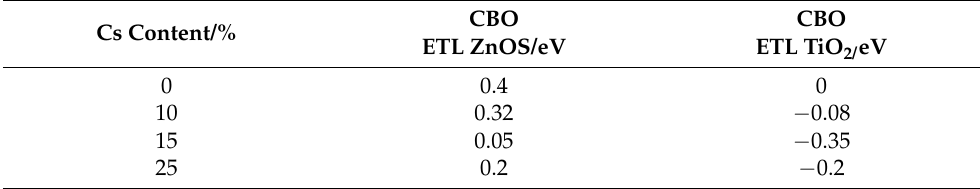
Table 4. CBO for ETL ZnOS and TiO 2 per Cs content.